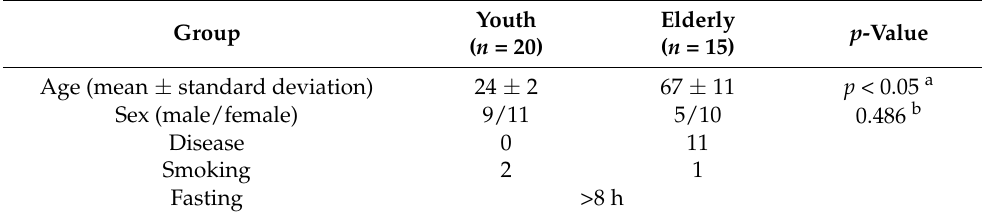
Table 1. Demographic information of subject group.